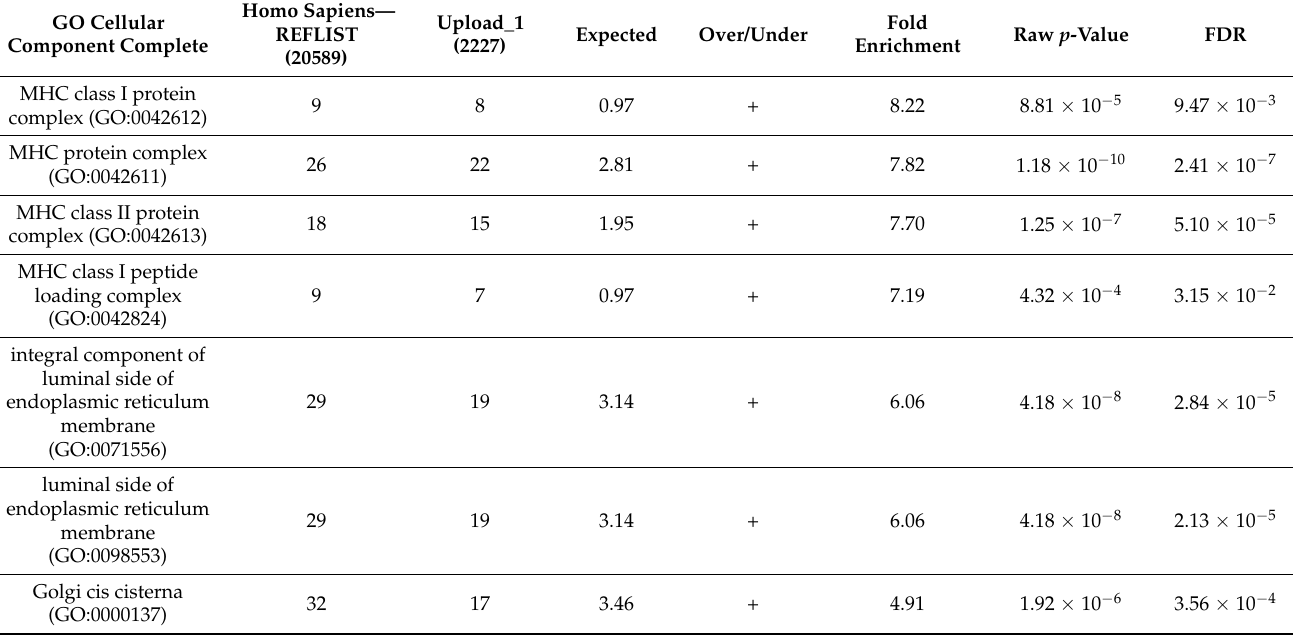
Table 3. GO cellular components in 122 CRC patients with CNAs in CIITA